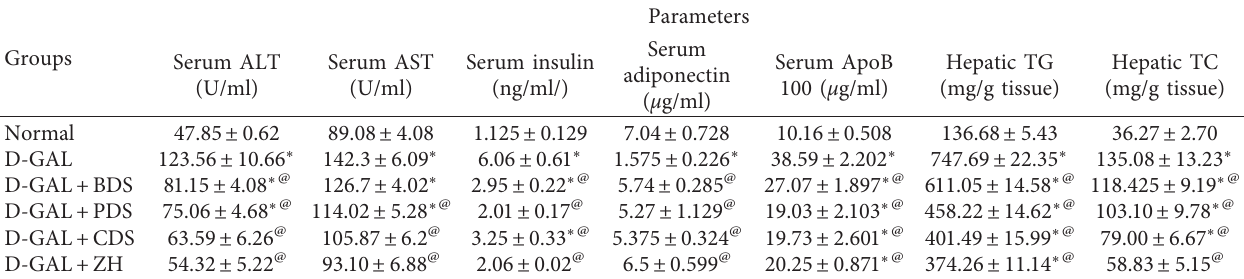
Table 2: Effect of D. salina on hepatic biochemical parameters in albino rats with age-related hepatic